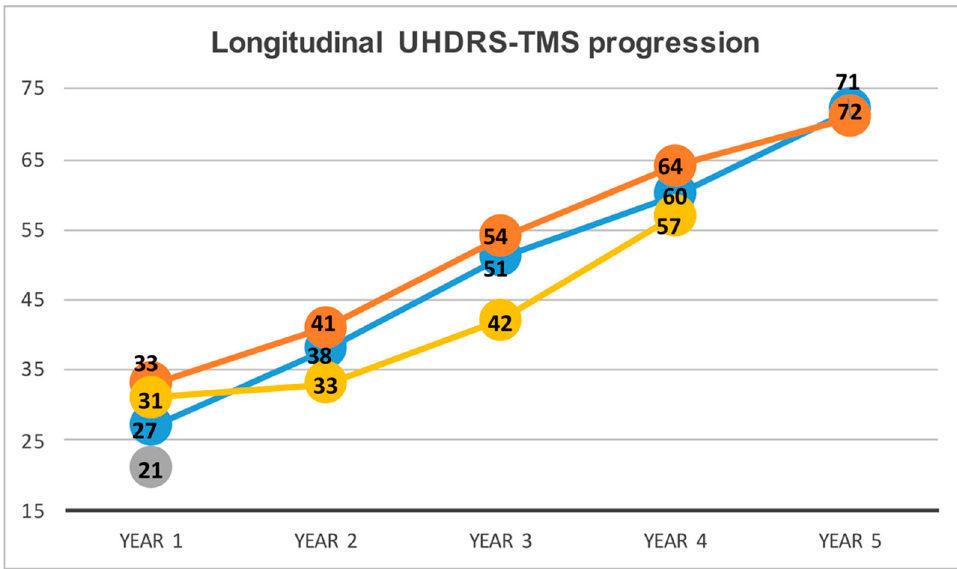
Figure 2. Longitudinal UHDRS-TMS progression. UHDRS: Unified Huntington’s Disease Rating Scale. TMS: total motor score. Each line refers to a single patient. Three out of four patients showed a remarkable yearly TMS change indicating a severe motor progression of the disease. TMS is reported within each circle. Orange = Patient 1, yellow = Patient 2, blue = Patient 4 and grey = Patient 3, the youngest patient, with only a basal assessment was available. Table 3. Cognitive and behavioral assay.